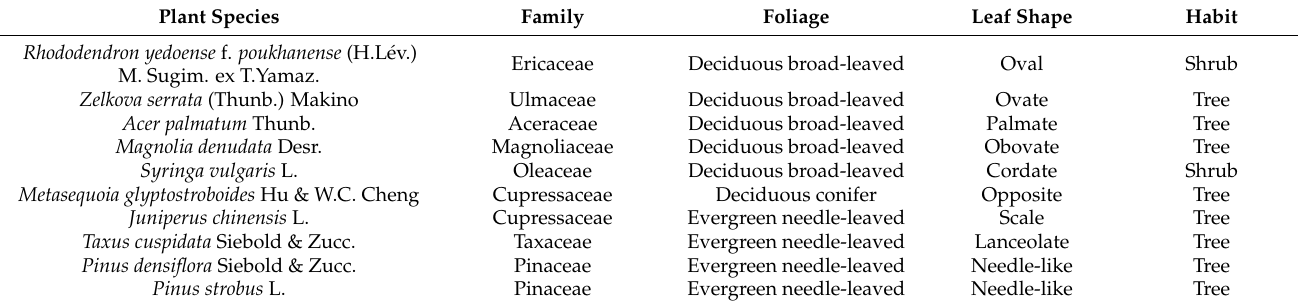
Table 1. Scientific name and leaf shape of 10 plant species sampled in this study.